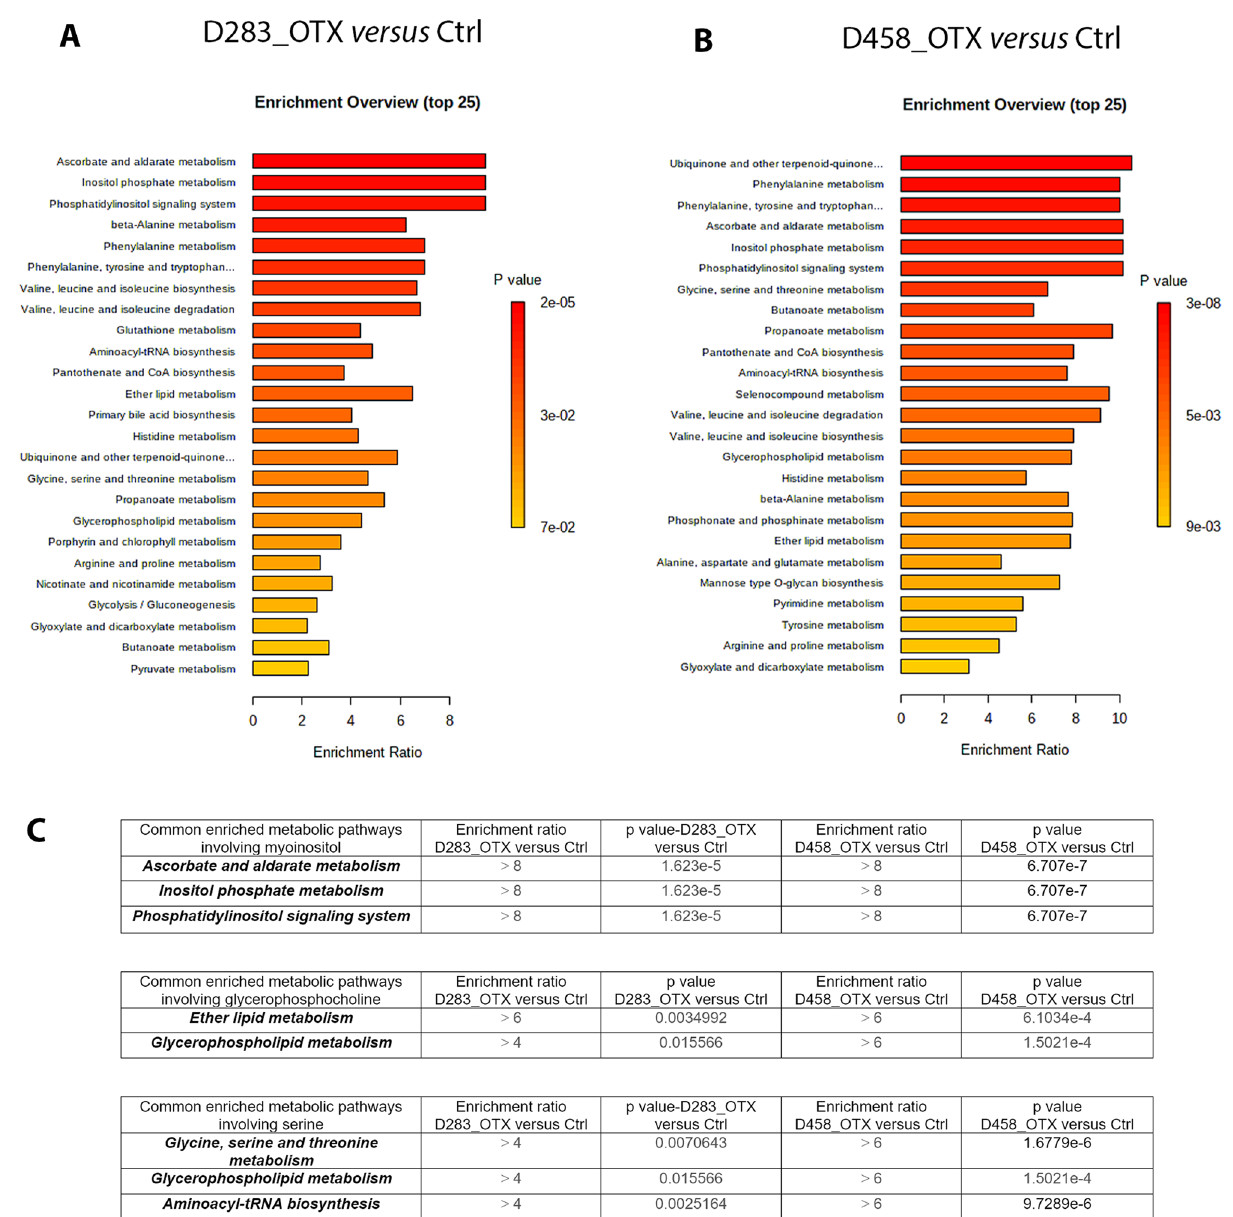
Figure 5. Summary plot of the metabolite set enrichment analysis (MSEA) of the identified metabolites in ( A ) D283_OTX versus D283_Ctrl and ( B ) D458_OTX versus D458_Ctrl. Horizontal graph bars indicate the pathways that are enriched in these groups. The colour code corresponds to the calculated p -value. Vertical red lines indicate pathways with a p -value < 0.05. ( C ) Summary table of the pathways commonly enriched in both the cell lines upon OTX-015 treatment and with a p -value < 0.05 are